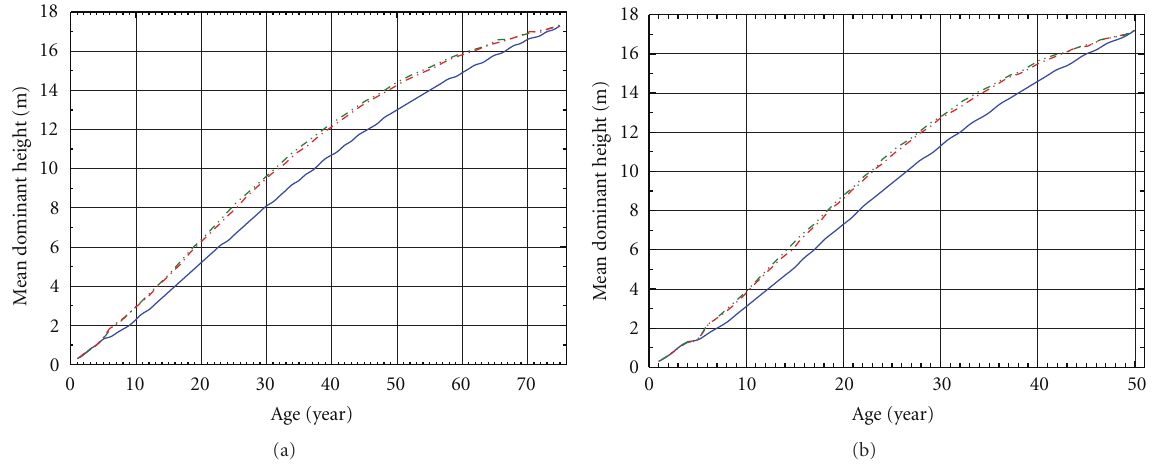
Figure 2: Fifty-year temporal size-density trajectories for upland black spruce plantations situated on good-excellent quality sites (site index = 18): Regime 1: no FVM treatment applied; Regime 2: FVM treatment with an expected e ff ect of a 15.7% height gain at age 7; and Regime 3: FVM applied with an expected e ff ect of a 40.0% height gain at age 7. Graphical denotations are given in Figure 1.